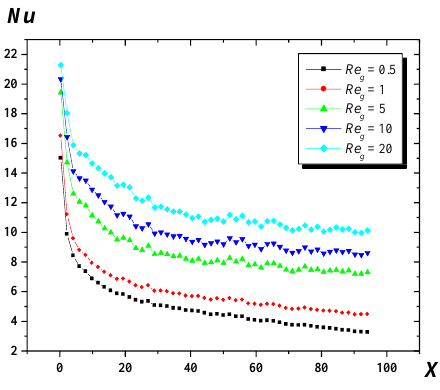
Fig. 5. Evolution of the Nusselt number along the pipe.